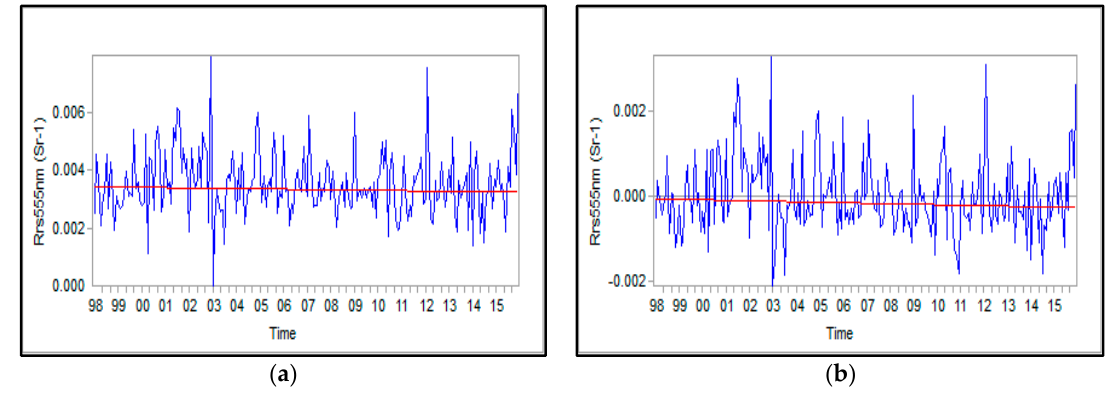
Figure 7. Time series of Rrs_555nm in the (SCS): absolute values ( a ) and anomalies ( b ).